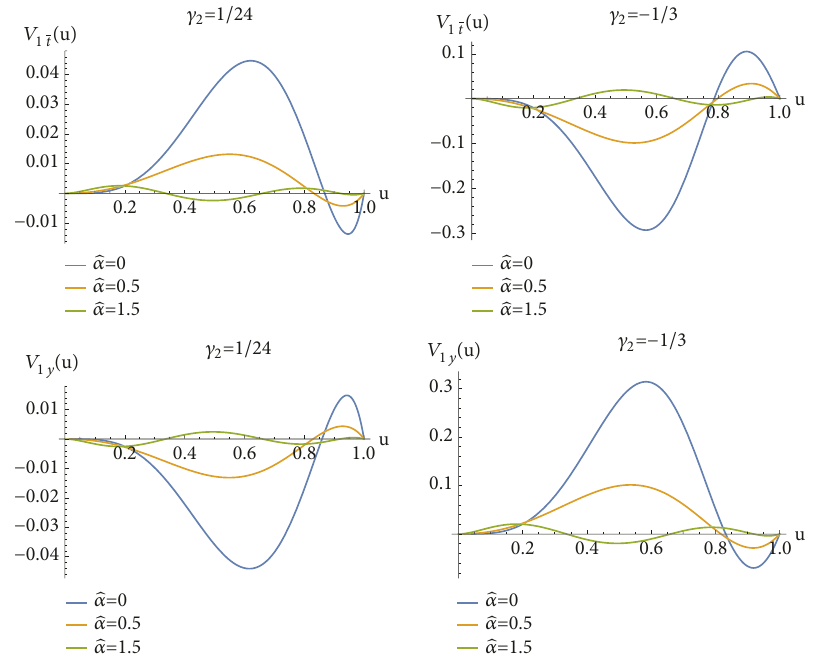
Figure 16: The potentials 𝑉 1𝑡 (𝑢) (plots above) and 𝑉 1𝑦 (𝑢) (plots below) for sample 𝛾 2 and ̂𝛼 .